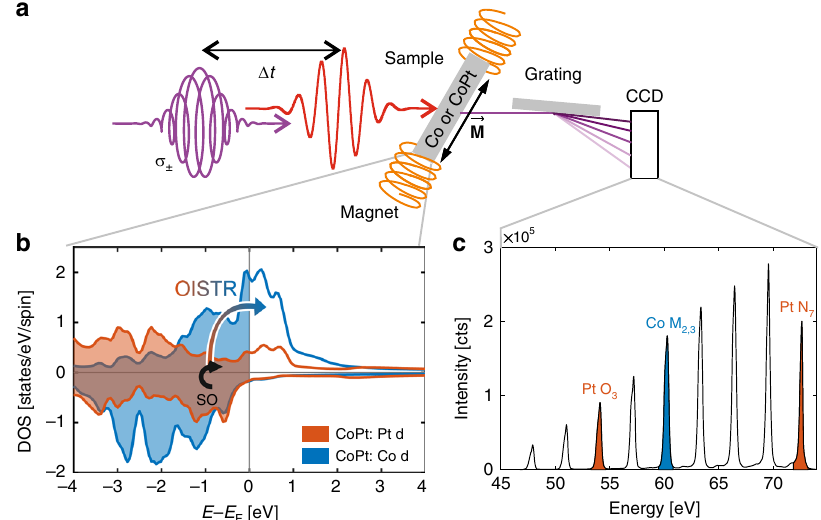
Fig. 1 Experimental set-up and microscopic mechanism of OISTR in CoPt. a Experimental geometry showing the optical excitation pulse as well as the time-delayed, circularly polarized XUV pulse ( σ ±). The XUV pulse is transmitted through the sample, energetically dispersed by a grating and then detected by a CCD camera. b Spin-dependent d -DOS of Co and Pt of the Co 50 Pt 50 alloy. The high spin-orbit coupling on Pt 5 d leads to an enhanced spin- fl ip rate localized on the Pt atom (black arrow). The colored arrow denotes the OISTR process; minority carriers are optically excited from Pt 5 d to Co 3 d states. c The measured high harmonic spectrum with indicated resonances for Pt O 3 and N 7 and Co M 2,3